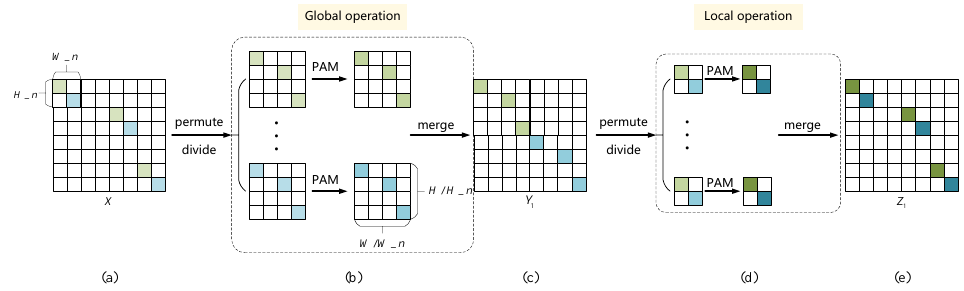
Figure 3. The structure of the proposed sparse position self-attention module (SPAM). ( a ) The input image is divided along position dimension. ( b ) PAMs are performed in rearranged small regions. ( c ) The pixel position of the feature map is restored to the original combination. ( d ) PAMs are performed in restored sub-regions. ( e ) The output of SPAM is obtained.